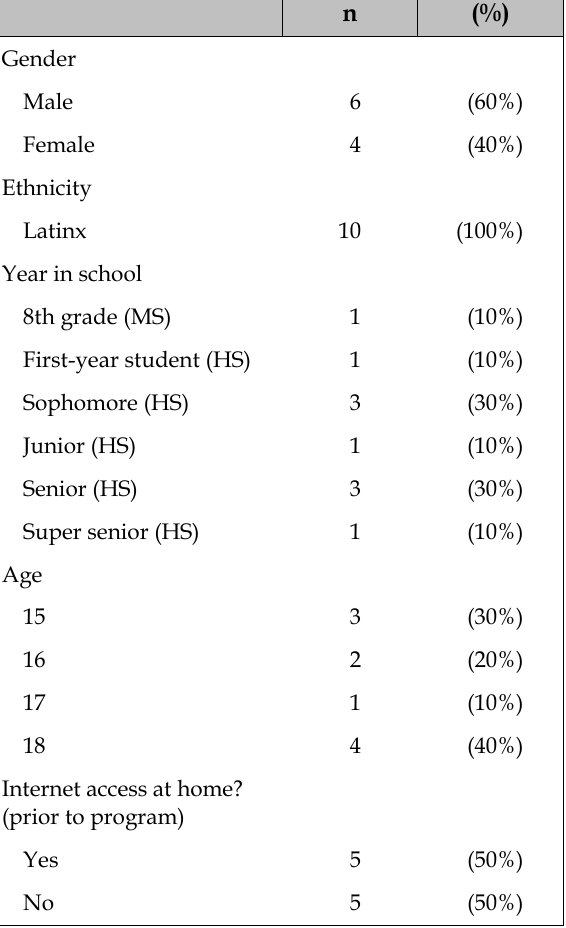
Table 1 Participant demographics,